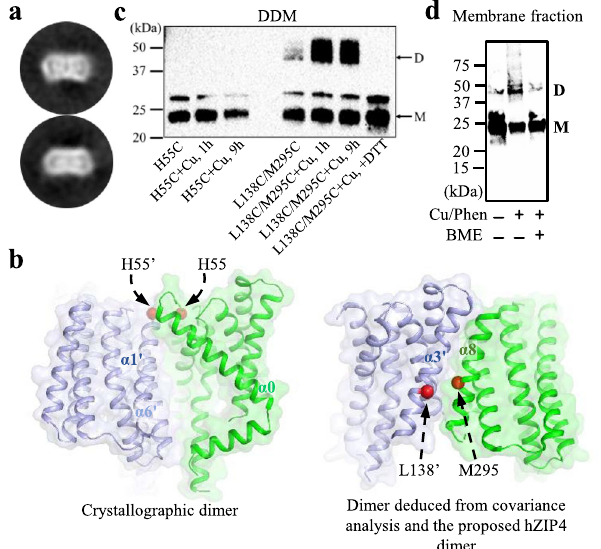
Fig. 5 | Dimerization of BbZIP. a Cryo-EM of BbZIP in Amphipol A8-35. Near symmetrical dimer can be visualized in selected 2D images. b Comparison of the crystallographic dimer observed in the apo state structure and the dimer deduced fromthecovarianceanalysisandthepreviouscomputationalstudyonhumanZIP4. BbZIP is shown in cartoon and surface modes. The C α atoms of the residues sub- jected to mutation into cysteine are shown in red spheres. c Chemical crosslinking of thepuri fi ed H55Cand L138C/M295CvariantsusingCu(II)-(1,10-phenanthroline) 3 complex (Cu/Phen) under the indicated conditions. Non-reducing SDS-PAGE and Western blot using the anti-Histag antibody were conducted to detect disul fi de bond mediated dimerization. d Chemical crosslinking of the L138C/M295C variant inthemembranefractionusingtheCu/Phencomplex.Monomeric(M)anddimeric (D) species are indicated. Source data are provided as a Source Data fi